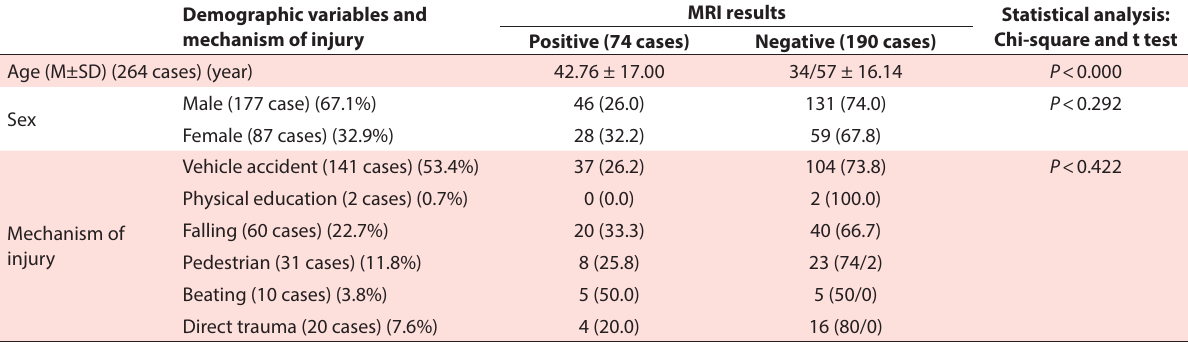
Table 1. Frequency distribution, demographic variables and mechanism of injury based on positive or negative MRI findings Demographic variables and mechanism of injury